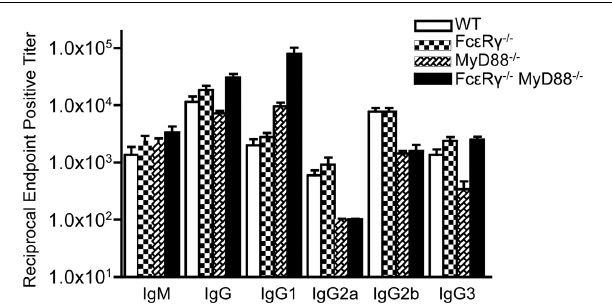
FIGURE 4 | Anti- B. burgdorferi IgG subclass titers are different in the single and double knockout mice. Anti- B. burgdorferi specific titers were determined by ELISA and are reported as the reciprocal of the endpoint positive titers. The Fc ε R γ − / − MyD88 − / − anti- B. burgdorferi IgG1 titers are significantly higher than the MyD88 − / − titers ( P = 0.0113). The MyD88 − / − IgG 3 titers are significantly lower than the Fc ε R γ − / − MyD88 − / − titers ( P = 0.0025) as well as the WT and Fc ε R γ − / − titers ( P = 0.01 and.0025,